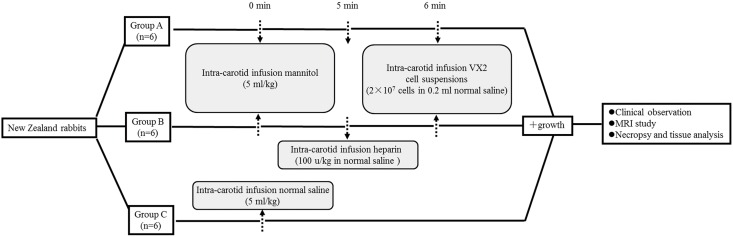
Flow chart of the experiment design.